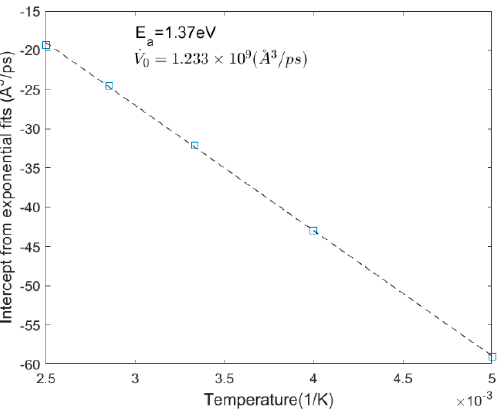
Figure 11. Arrhenius plot of ordinate intercepts from linear curve fits in Figure 10, showing Arrhenius behavior consistent with the theory of thermally activated crack growth.